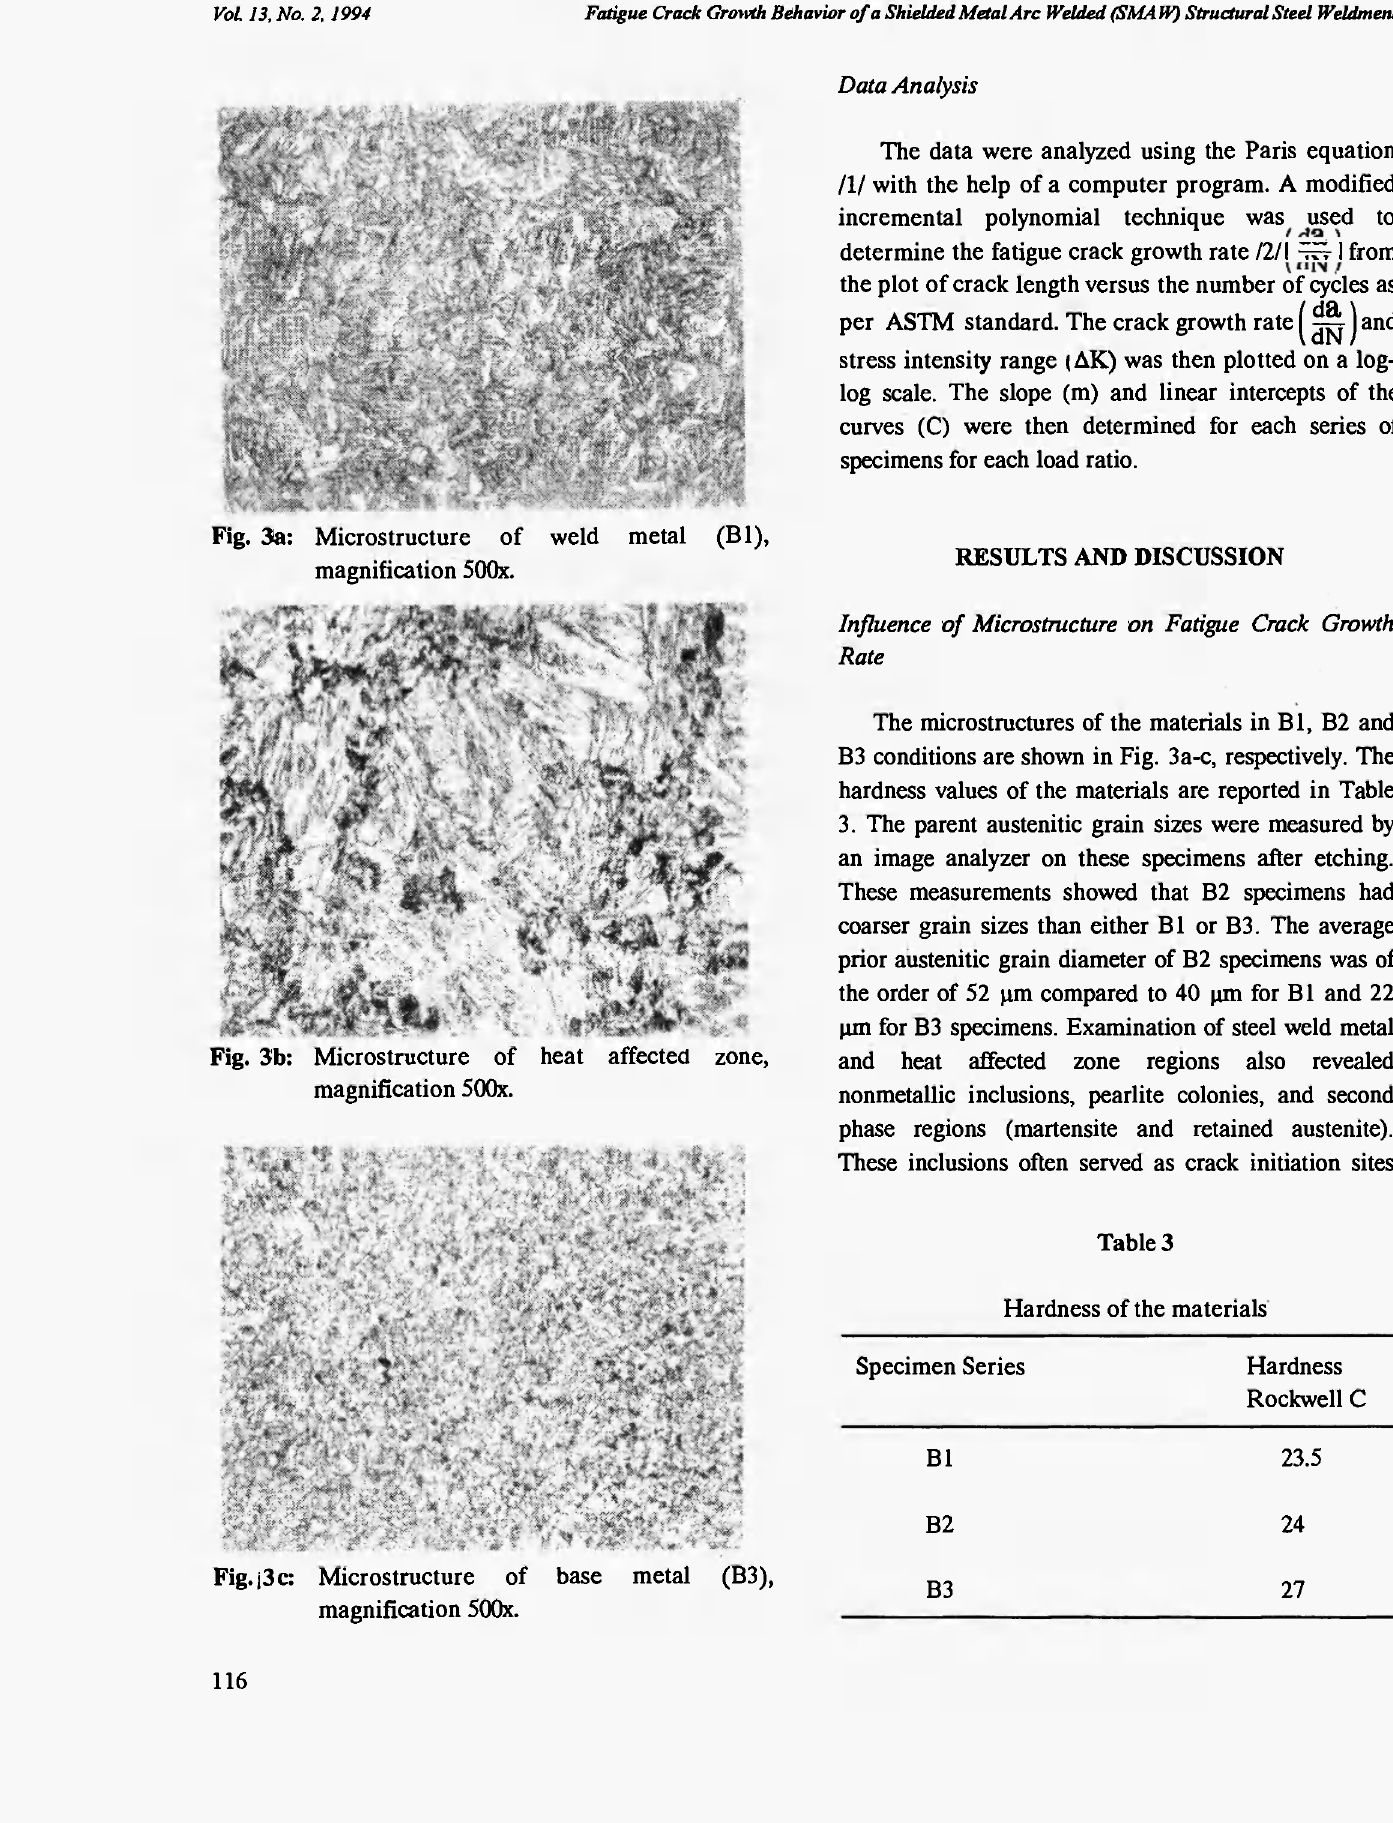
Fig. 3a: Microstructure of weld metal (Bl), magnification 500x.